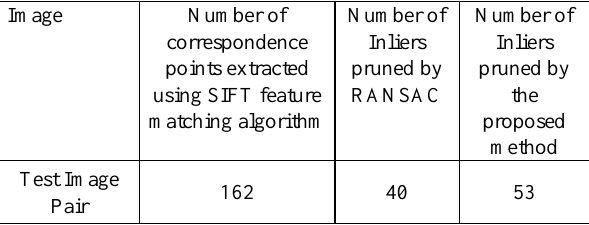
Table 1. Comparative result of the proposed method with RANSAC